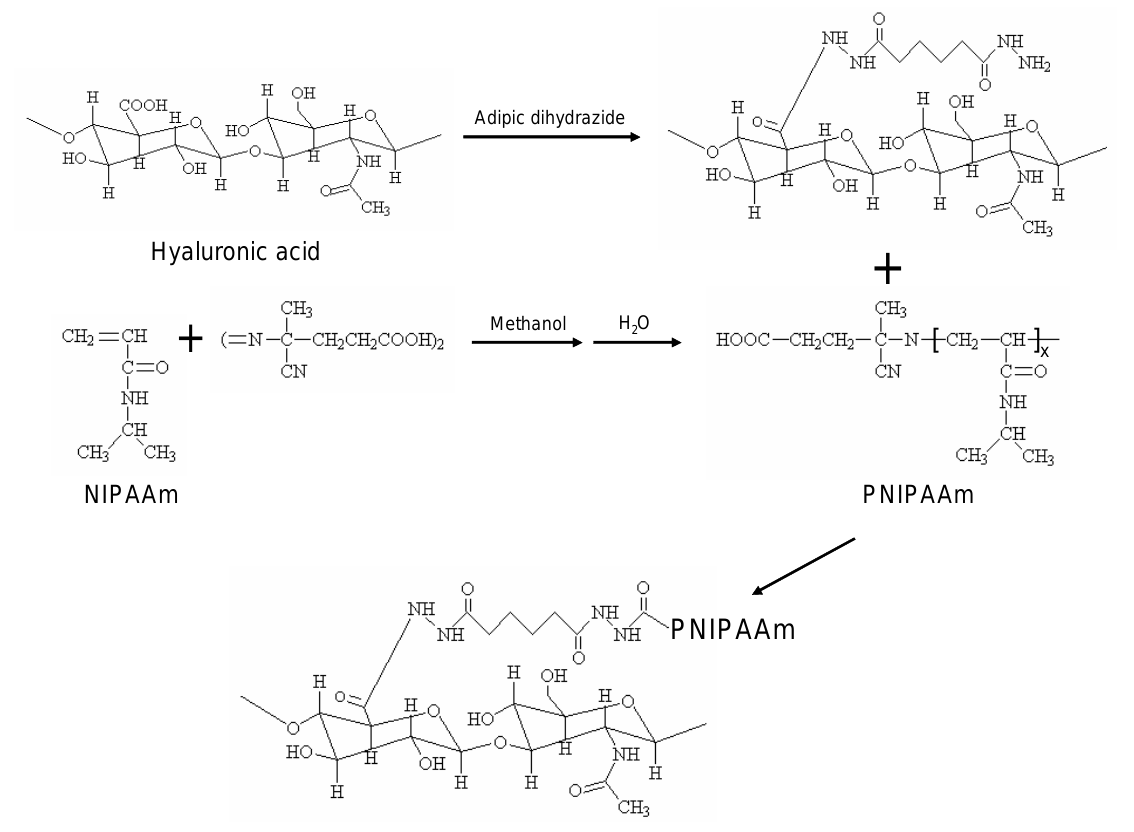
Figure 2. Synthetic route of PNIPAAm-grafted aminated hyaluronic acid